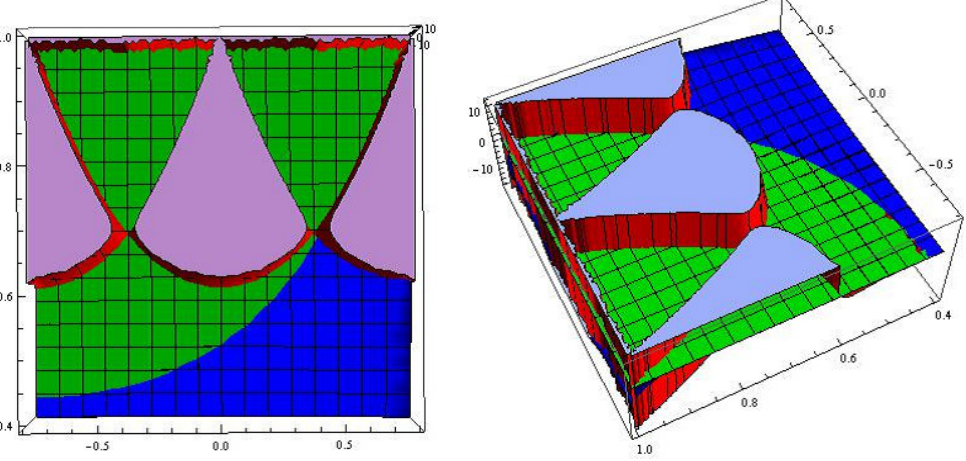
Figure 8. The graph of x 3 = det W (the red domain), the plane x 3 = 0 (the green domain), and x 3 = (